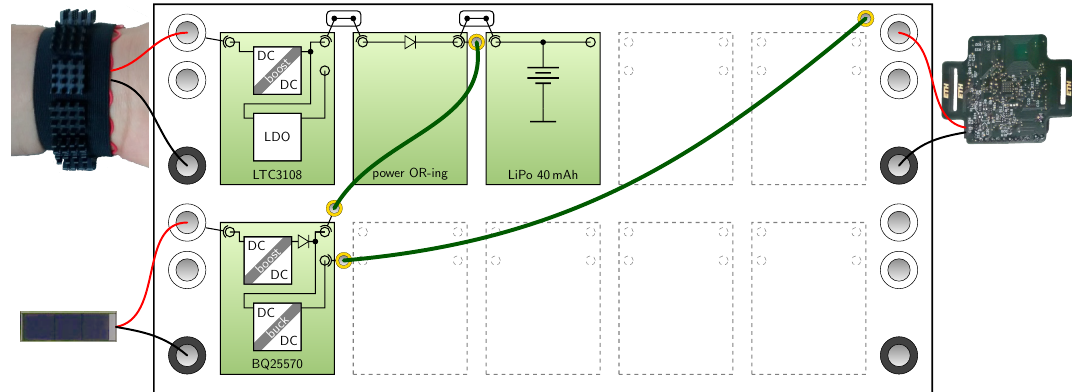
Figure 9. Power management of InfiniTime [23] rebuilt with